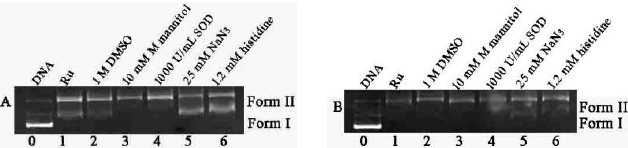
Figure 8. The mechanism experiments of DNA photocleavage. ( A ) complex 1 (20 μ M), and ( B ) 2 (10 μ M) incubating with different scavengers under 60 min irradiation(365 nm). (10 µ M) incubating with different scavengers under 60 min irradiation (365